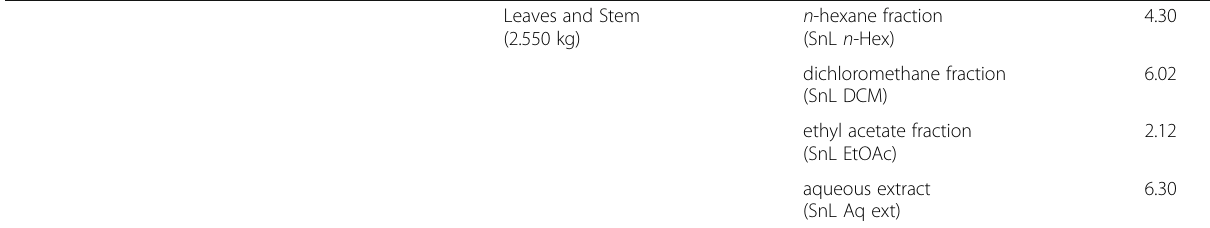
Table 2 Details of extraction and fractionation of medicinal orchids obtained from AR (Continued)